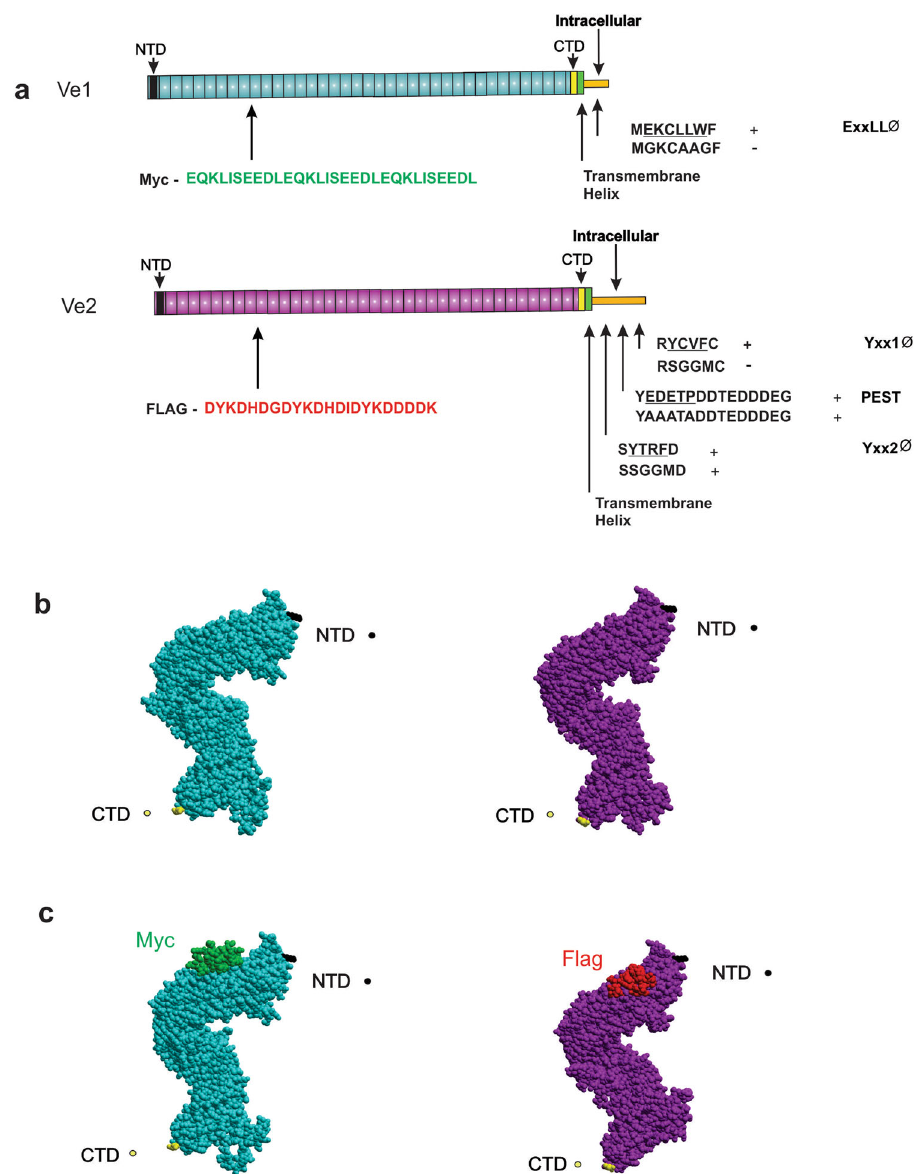
Fig. 2 Signal positions and predicted secondary structure of Ve receptors. a Insertion sites of the myc-Ve1 (green) and FLAG-Ve2 (red) are shown in a series of modi fi ed receptors in relation to N-terminal (black), the hydrophobic plasma membrane spanning (green), and intracellular (gold) region with the putative C-terminal (yellow) signals. In fl uence of residue changes are indicated ( + or -) for Ve1E/DXXXL Φ , Ve2YXX Φ 1, Ve2YXX Φ 2, Ve2PEST and surrounding sequences. b Model of the Ve receptor ectodomains based on the GSO1 protein kinase (Ve1 blue and Ve2 purple) showing the proximity of the N-terminal (black Ve1 K38 and Ve2 K36) and C-terminal (yellow Ve1 N983 and Ve2 V982) domains. Models were generated with MolSoft (San Diego, CA). c Locations of the inserted Ve1 Myc (green) and Ve2 FLAG (red) epitopes and impact on the modelled receptor